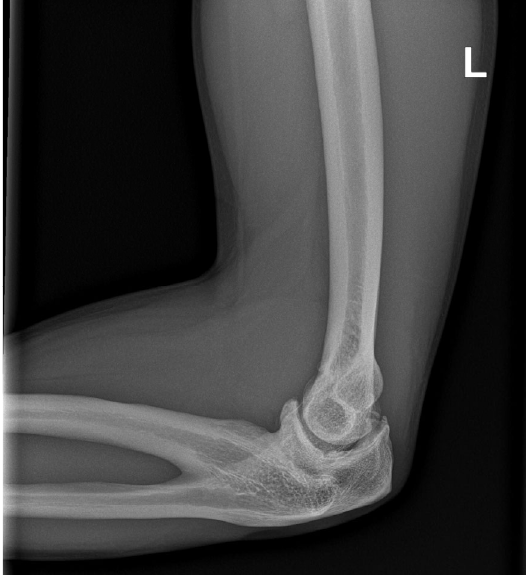
Figure 4. Radiographic image of the elbow joint in lateral view. Markable osteophytic changes of olecranon and coronoid process are present.